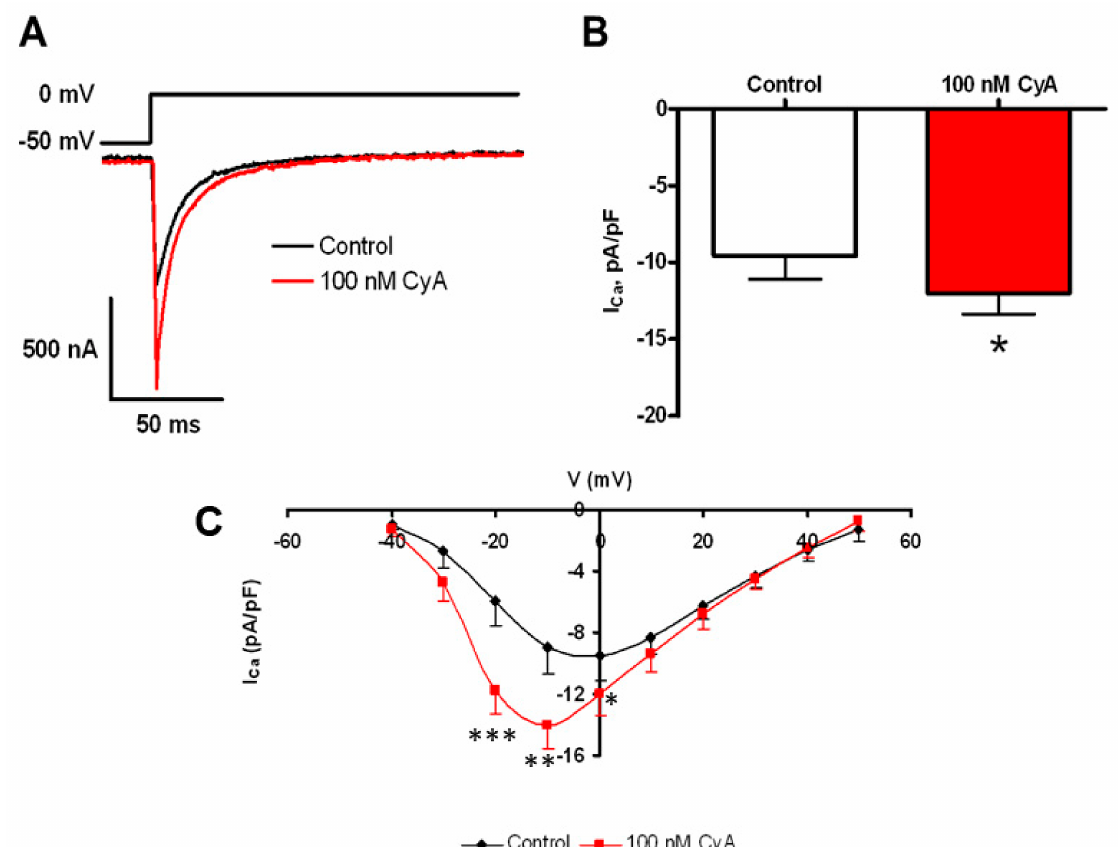
Figure 8. PP inhibition-induced potentiation of L-type Ca 2+ current amplitude. ( A ) The voltage clamp protocol and representative original L-type Ca 2+ current recordings prior to and during PP inhibition by CyA. Average effects of CyA on the amplitude ( B ) and current-voltage relationship ( C ) of I Ca in SANC ( n = 9). L-type Ca 2+ current amplitudes were normalized to membrane capacitance. * p < 0.05, ** p < 0.01, *** p <